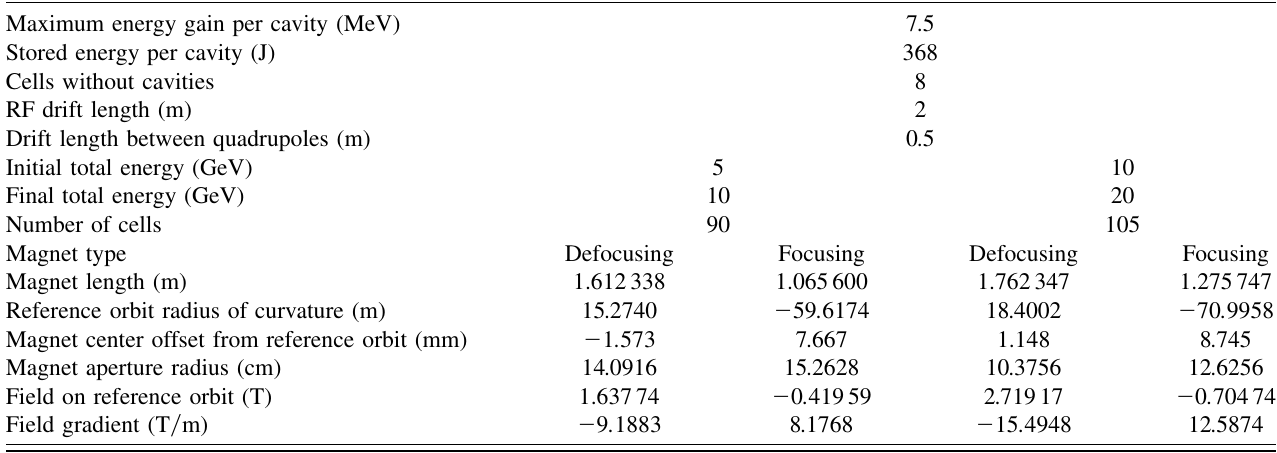
TABLE VI. Parameters for FFAG lattices. See Fig. 28 to understand the signs of the